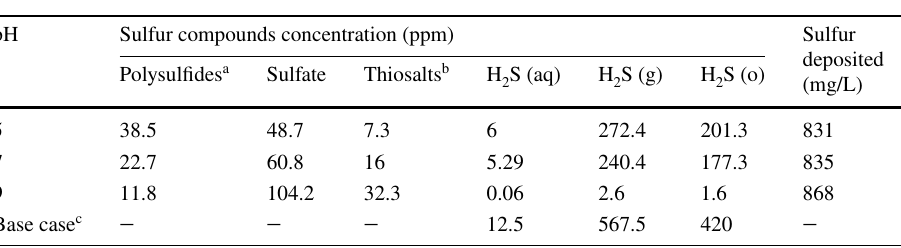
Table 4 Comparison of the results of sulfur speciation for three cases at T : 15 °C, P : 1 MPa